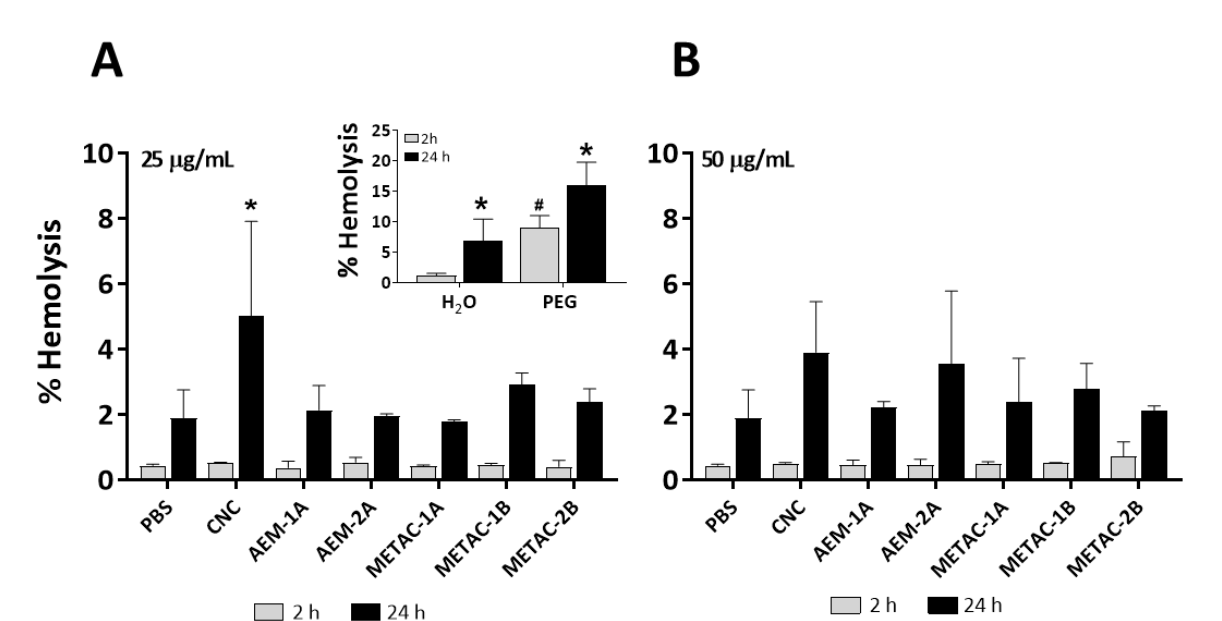
Figure 1. Hemolytic activity of unmodified and modified CNCs in human red blood cells (RBC). Percentage of hemolysis induced by 25 µg/mL ( A ) and 50 µg/mL ( B ) after 2 h (gray bars) and 24 h (black bars) of exposure in diluted human blood with respective concentrations of CNCs. PEG 1 mg/mL, ultra-pure H 2 O, and Triton-X-100 1% (100% hemolysis, not shown) were used as positive controls (insert in A ) and PBS as negative controls ( A , B ). * p < 0.05 vs. PBS 24 h; # p < 0.05 vs. PBS 2 h (Tukey’s).